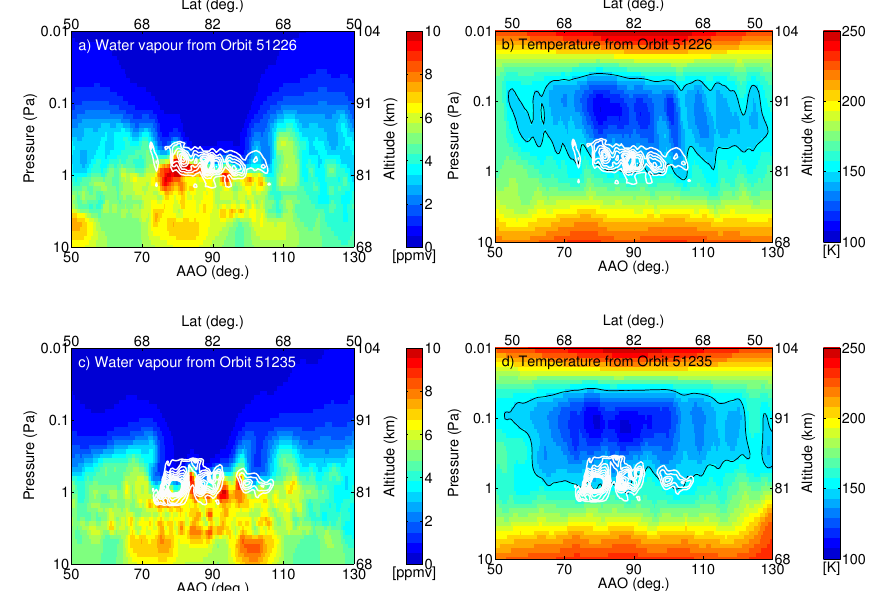
Figure 14. Water vapour (left column) and temperature (right column) fields from two orbits 15 July 2010. The white contours show the volume scattering coefficient from OSIRIS, where each contour corresponds to 1 × 10 − 9 m − 1 str − 1 . The 150K temperature contour is given by the black line in the temperature panels. The lower x -axis shows the AAO and the top axis shows the true latitude of the measurements.